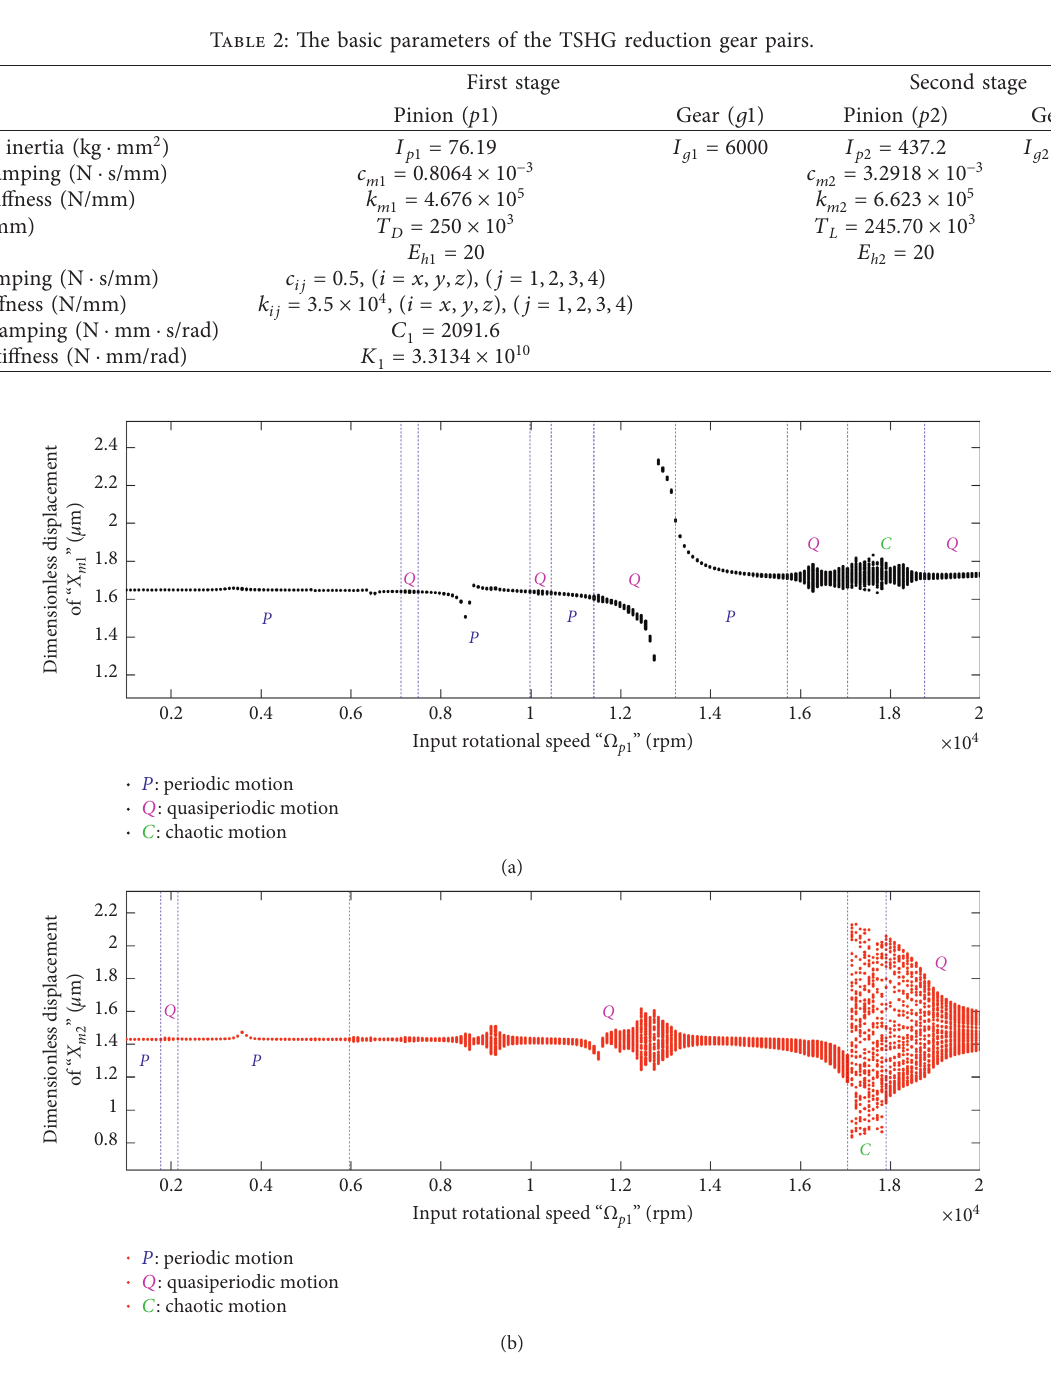
s � s � 40 μ m . (a) X 1 2